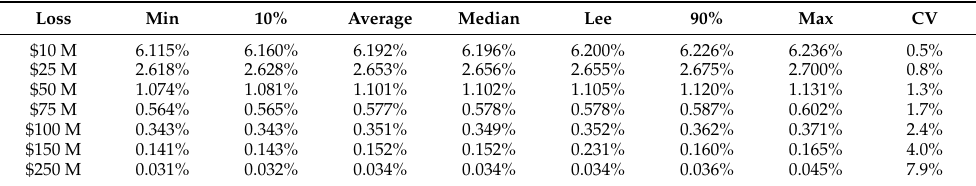
Table 10. Bootstrap for 500K30 simulation of the Model Portfolio loss values to determine the probability ranges for individual loss values. The 10% and 90% headers indicate the probability of the damage exceeding raw loss value. CV is the coefficient of variation (Standard Deviation/Average). The Lee (Lee et al. 2021) values are the probabilities associated with the original simulation data set. The remaining values were determined from the statistics of the resampled sets using the P ERCENTILE .I NC .